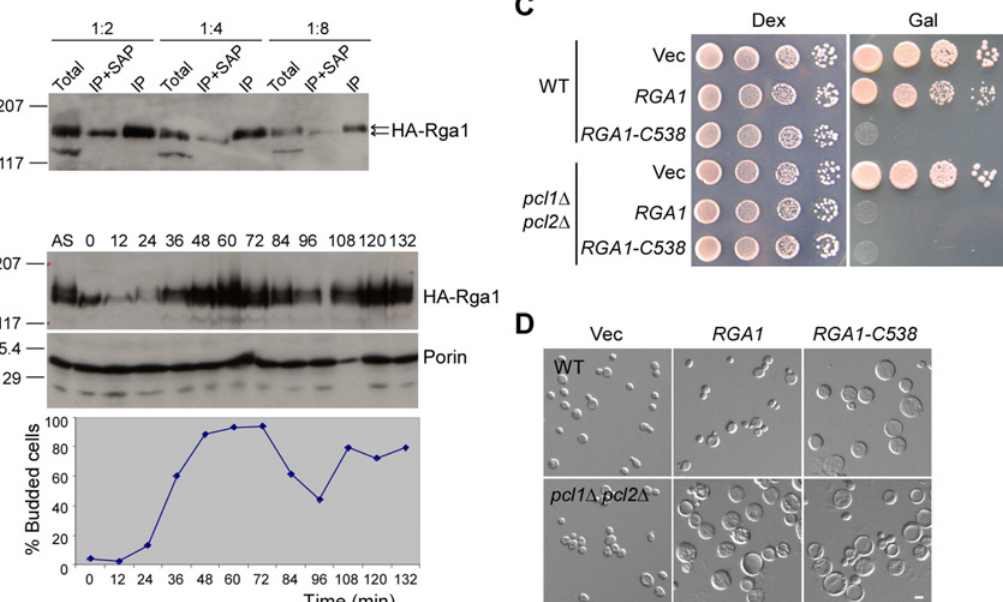
Fig 2. Rga1 may be negatively regulated by phosphorylation. (A) Rga1 is phosphorylated during the cell cycle. HA-Rga1 was immunoprecipated from cell lysates of strain YZT52 by anti-HA antibodies conjugated to Sepharose beads. Samples of cell lysates (total), immunoprecipates (IP), and shrimp alkaline phosphatase-treated immunoprecipates (IP+SAP) were diluted and analyzed by immunoblotting using anti-HA antibodies. Molecular weight (kDa) markers were shown. (B) Cells of strain YZT52 were synchronized in G1 with α factor (time 0) and then released into fresh medium. HA-Rga1 was analyzed by immunoblotting at indicated time points (min). Porin serves as a loading control. The percentage of budded cells at each time point was determined microscopically. AS, asynchronized culture. (C) Cells of strains BY448 (WT) and BY634 ( pcl1 Δ pcl2 Δ ) carrying pEGKT306 (Vec), pEGKT306-RGA1, or pEGKT306-RGA1-C538 were grown on SC-Ura (Dex) and SRG-Ura (Gal) plates at 30°C. Pictures were taken after 4 days. (D) DIC images of cells as in (C) were grown on SRG-Ura plate for 16 hr at 30°C. Bar, 5 μ m.